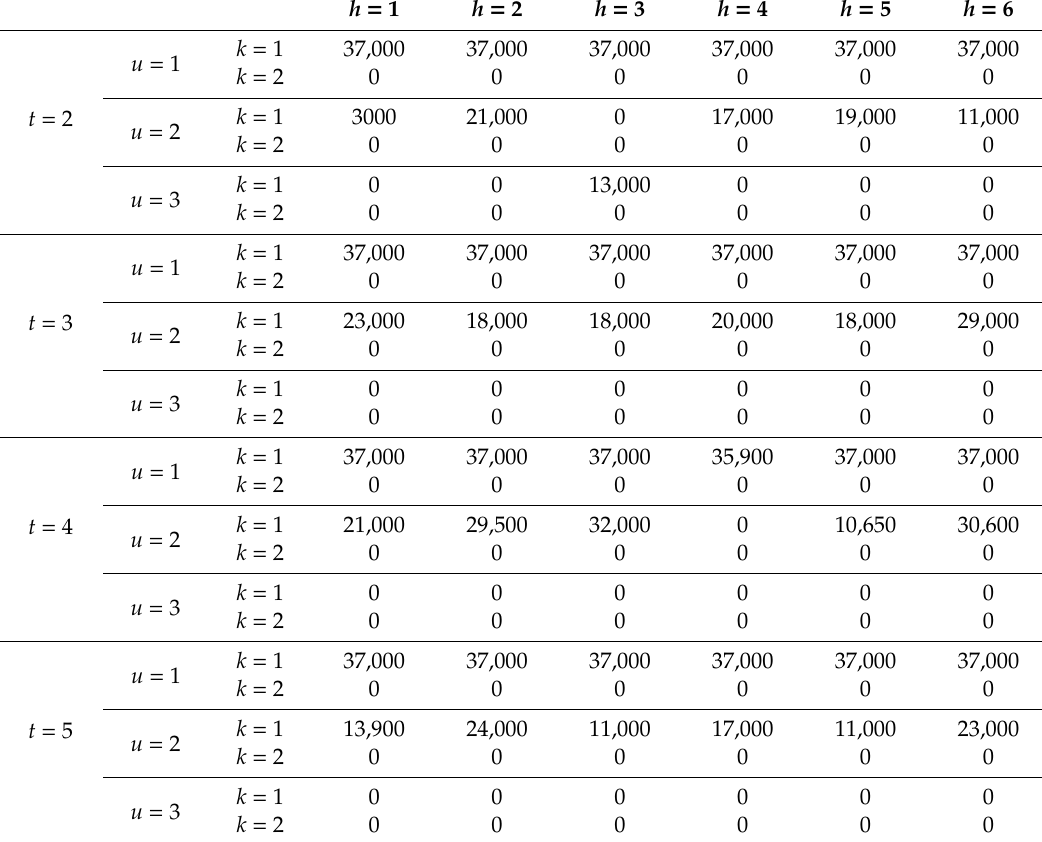
Table A3. Quantity of surgical instruments supplied by distributor d = 2 to all hospitals in period t =